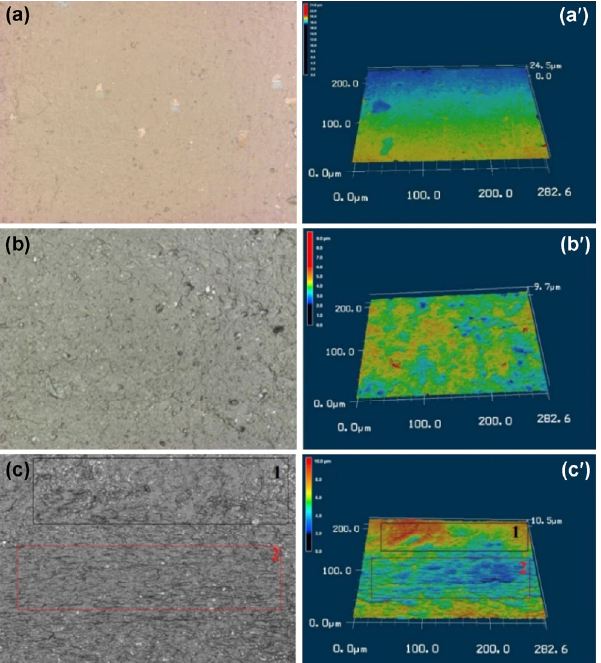
Fig. 10 Surface morphology and 3D morphology of the artificial skin; (a) the surface morphology of the artificial skin; (a') the 3D morphology of the artificial skin; (b) the surface morphology of the artificial skin tests with dry silk at 0.10 N, 5 mm/s; (b') the 3D morphology of the artificial skin tests with dry silk at 0.10 N, 5 mm/s; (c) the surface morphology of the artificial skin tests with dry silk at 2 N, 5 mm/s; (c') the 3D morphology of the artificial skin tests with dry silk at 2 N, 5 mm/s.